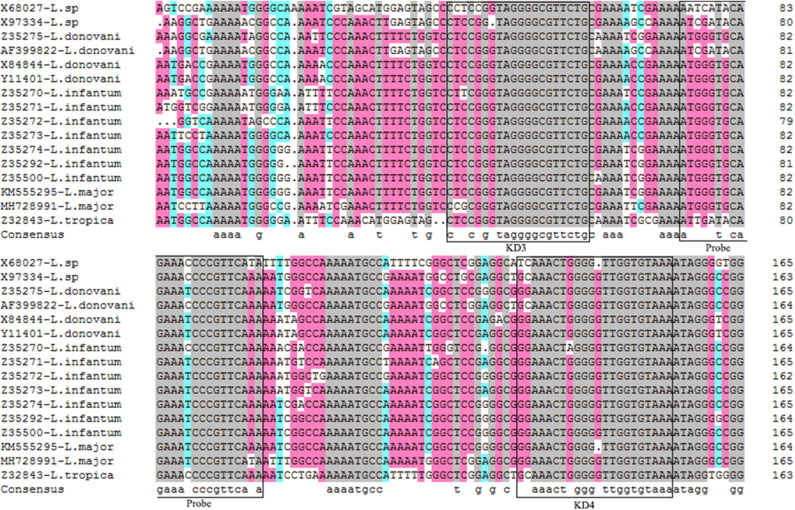
Alignments of mkDNA sequences from major Leishmania species. Sequences were aligned using CLUSTALW and prepared for display using BOXSHADE. Identical amino acids are shaded with different color. The consensus sequences were squared for making forward primer KD3 and reverse primer KD4, and probe. The gray mark represents the sequence homology 100%, the pink mark represents the sequence homology ≥75%, the blue mark represents the sequence homology ≥50%.